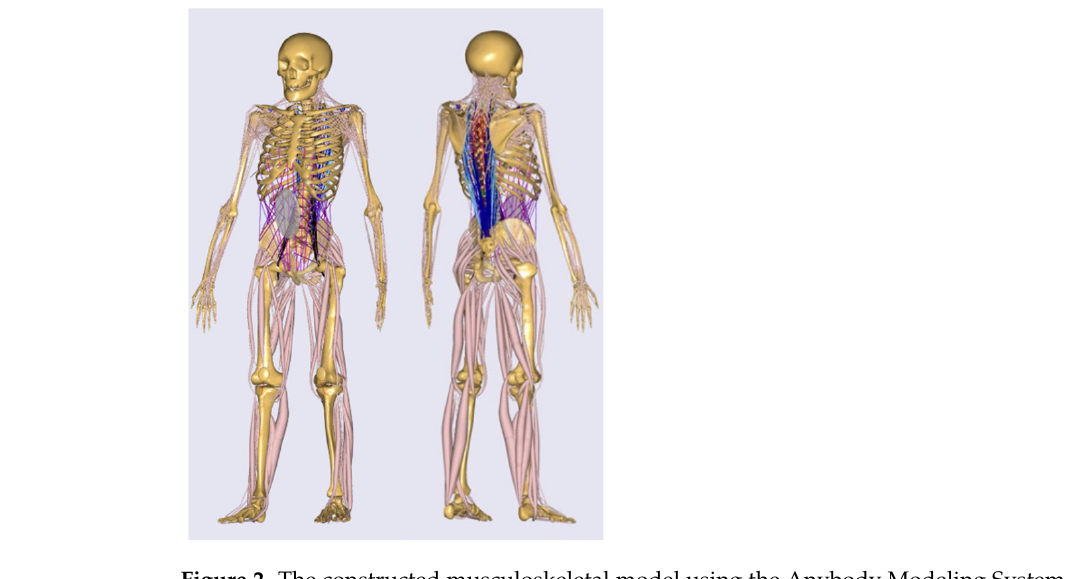
Figure 2. The constructed musculoskeletal model using the Anybody Modeling System. The con- structed full-body model altered the muscle pathways and divided the cervical and thoracic spine.